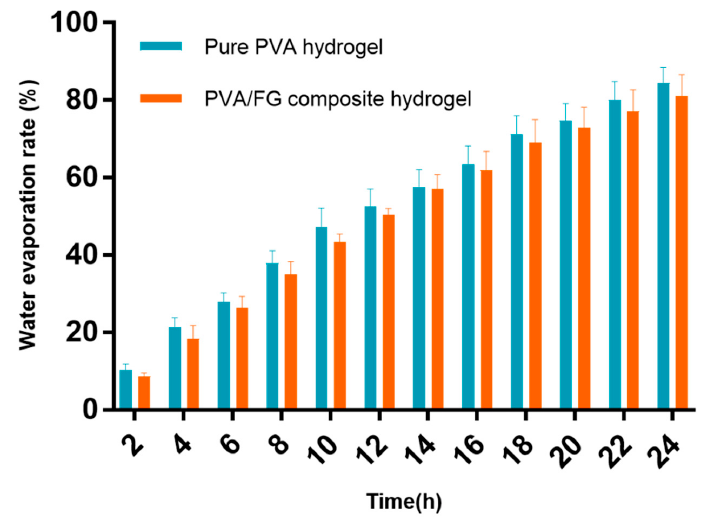
Figure 5. Water evaporation rate of pure PVA hydrogel and PVA/FG composite hydrogel.